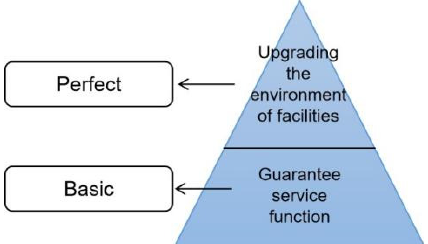
Figure 2. Logic of the parking facility quality improvement study.